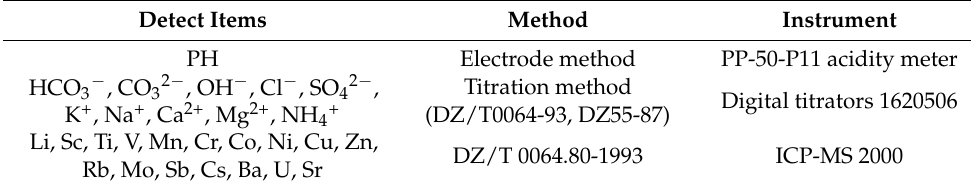
Table 4. List of test